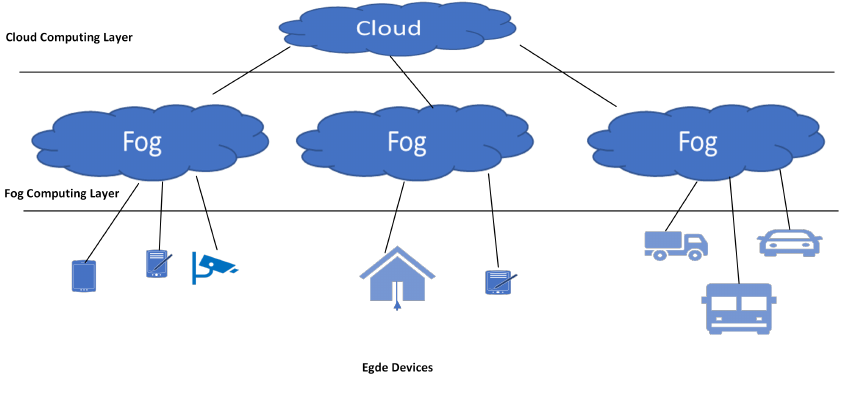
Figure 2. The fog computing